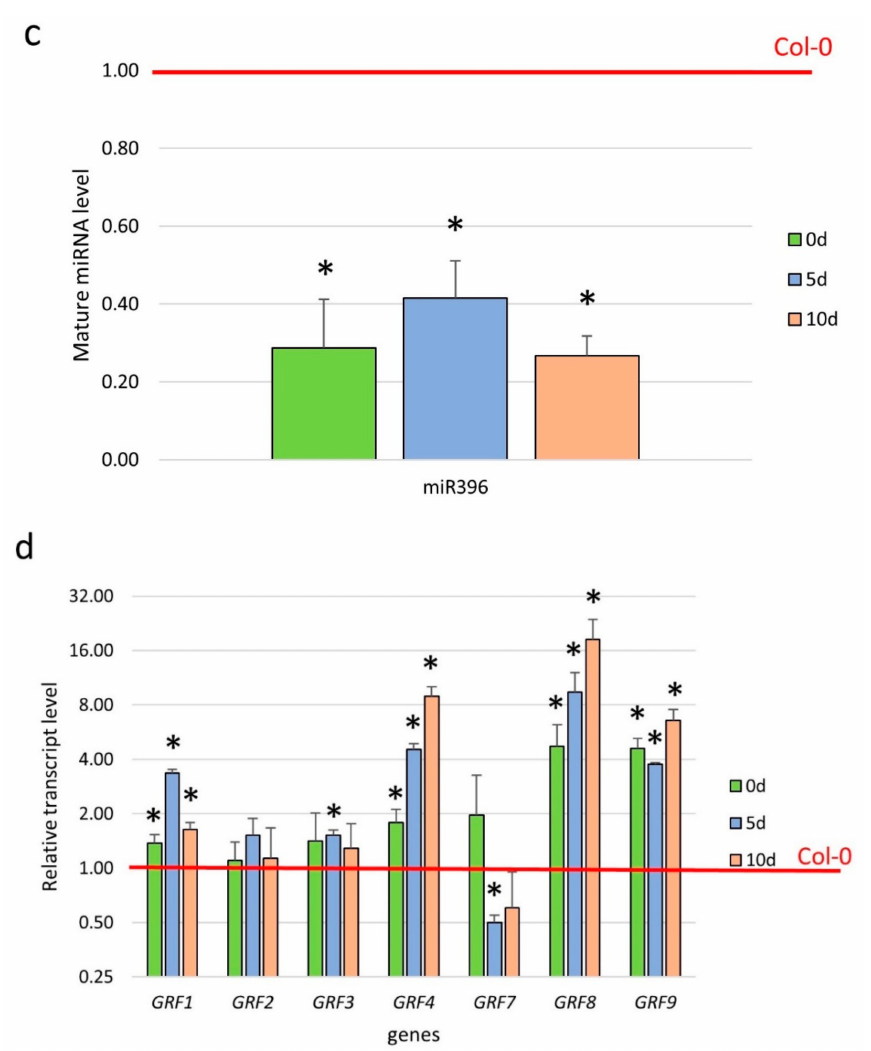
Figure 7. The regulatory relationship within the miR396–GROWTH REGULATING FACTOR (GRF)–PLETHORA (PLT) module. ( a ) The expression level of the PLT1 and ( b ) PLT2 genes in the cultures of the mir396 mutants and the 35S: MIR396b line; ( c ) the decreased accumulation of miR396 in the culture of the plt2 mutant; ( d ) the increased expression level of GRFs ( GRF1, GRF2, GRF3, GRF4, GRF7, GRF8 , and GRF9 ) in the culture of the plt2 mutant. The explants were cultured on a standard E5 medium. The relative transcript level was normalized to the internal control ( At4g27090 ) and calibrated to a WT (Col-0) culture of the same age. The bars represent the standard deviation. Values that were significantly di ff erent from those of the WT culture are indicated with asterisks (*) ( p < 0.05; n = 3 ±